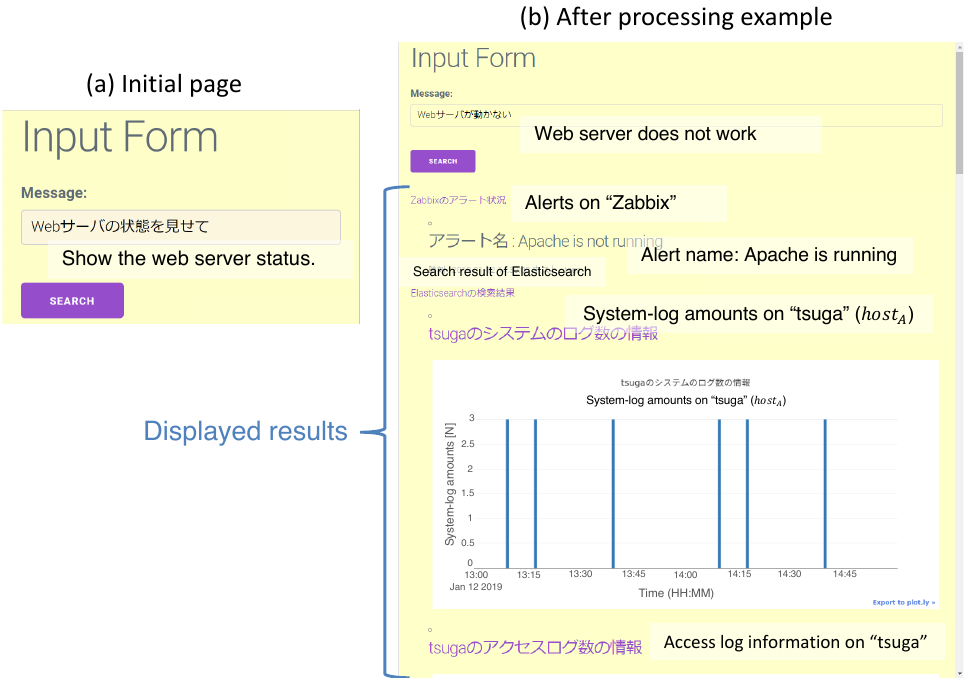
Figure 10. Screenshot of the UI server: ( a ) An initial state. We can input the request for the system in natural language and data processing starts when the user pushes the search button. ( b ) Example result after processing is complete. The results are ordered and displayed below the input